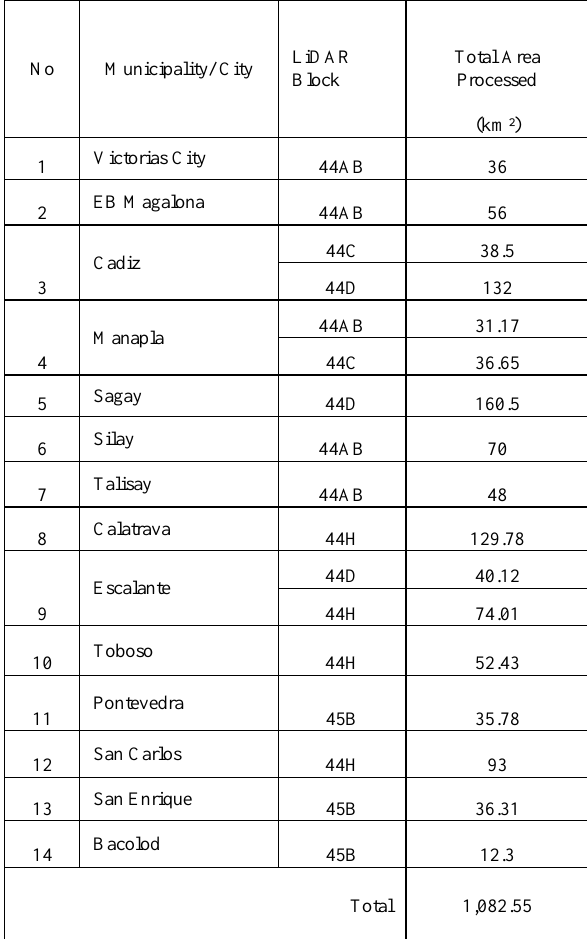
Table 3. Comparative Summary of the Accuracy Assessments of the coastal municipalities/ cities of Negros Occidental with LiDAR